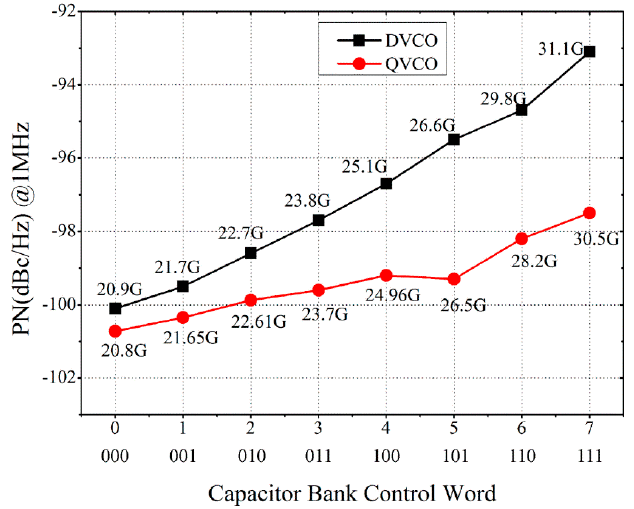
Figure 11. (cid:1842)(cid:1840) plot of DVCO and QVCO at 1 MHz offset frequency in the entire (cid:1846)(cid:1844) , representing Figure 11. PN plot of DVCO and QVCO at 1 MHz offset frequency in the entire TR , representing oscillation frequency taken at various capacitor bank control word. oscillation frequency taken at various capacitor bank control